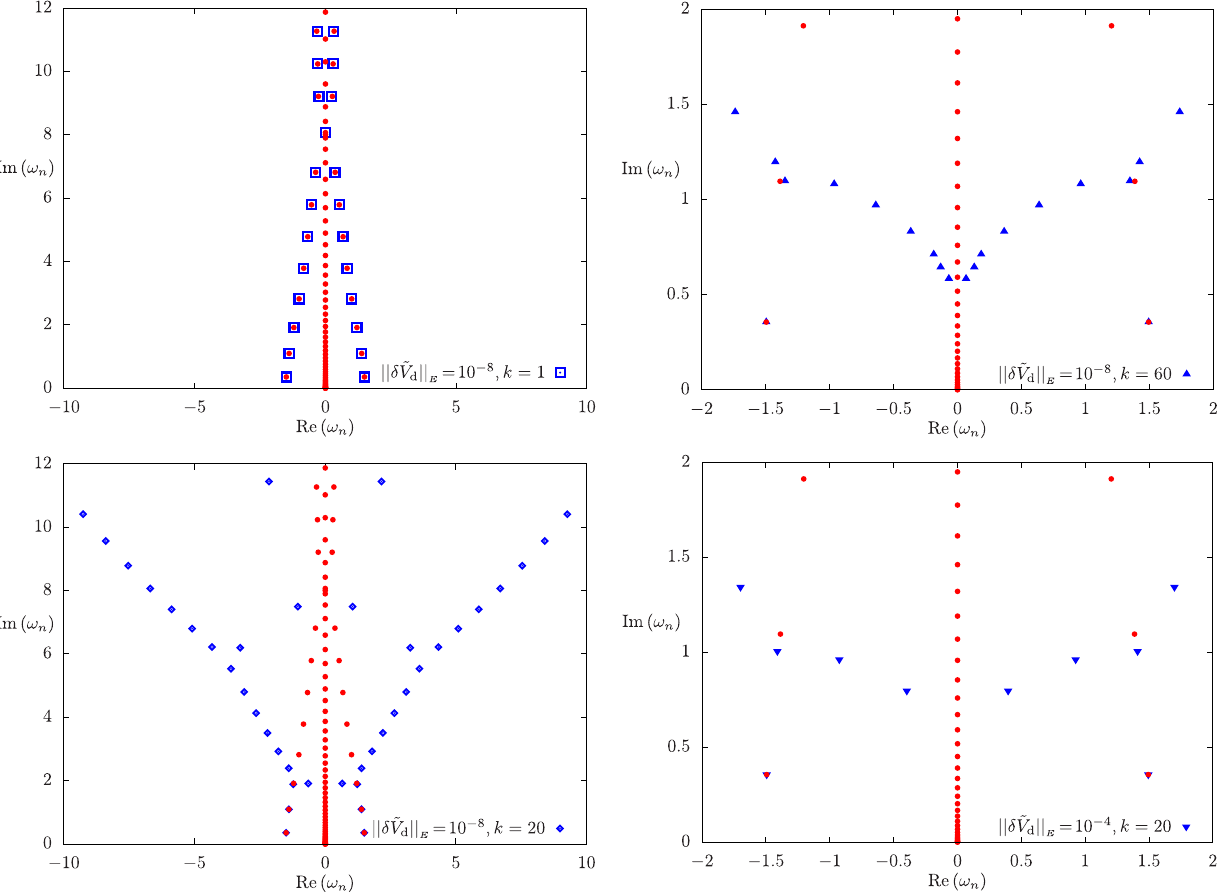
˜ V FIG. 14. QNM spectra for deterministic perturbations δ of Schwarzschild l ¼ 2 gravitational modes (here Regge-Wheeler, similar d behaviour for Zerilli, cf. Fig. 15), superimposed over the unperturbed values (red). Left column: stability under low-frequency perturbation (top panel) versus high-frequency instability of QNM overtones (bottom panel). Right column: zoom into the first QNM overtones, showing the instability of the first overtone by increasing (i) the frequency of the perturbation (top panel) and (ii) the (energy) norm of the perturbation (bottom